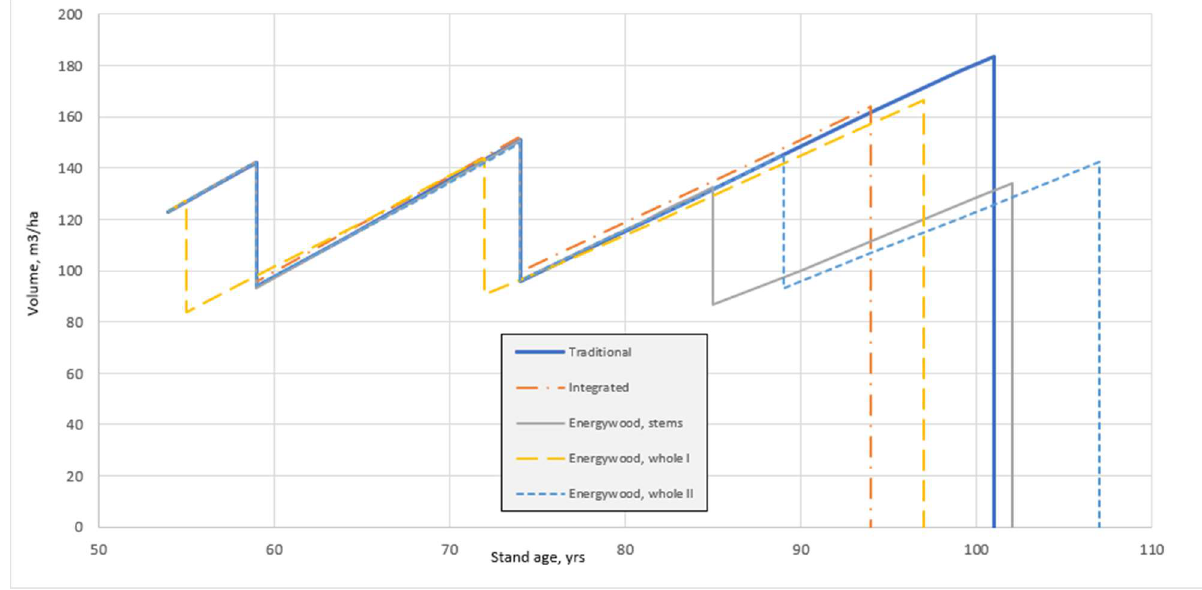
Figure 2. Volume of a growing stock associated with option 1 (traditional), 2 (integrated), 3 (energy wood, stems), 4 (energy wood, whole I) and 5 (energy wood, whole II) according to stand-level optimization in stand 1, m 3 ha −1 .FCT conducted at the stand age between 54 and 59 years, depending on the option.